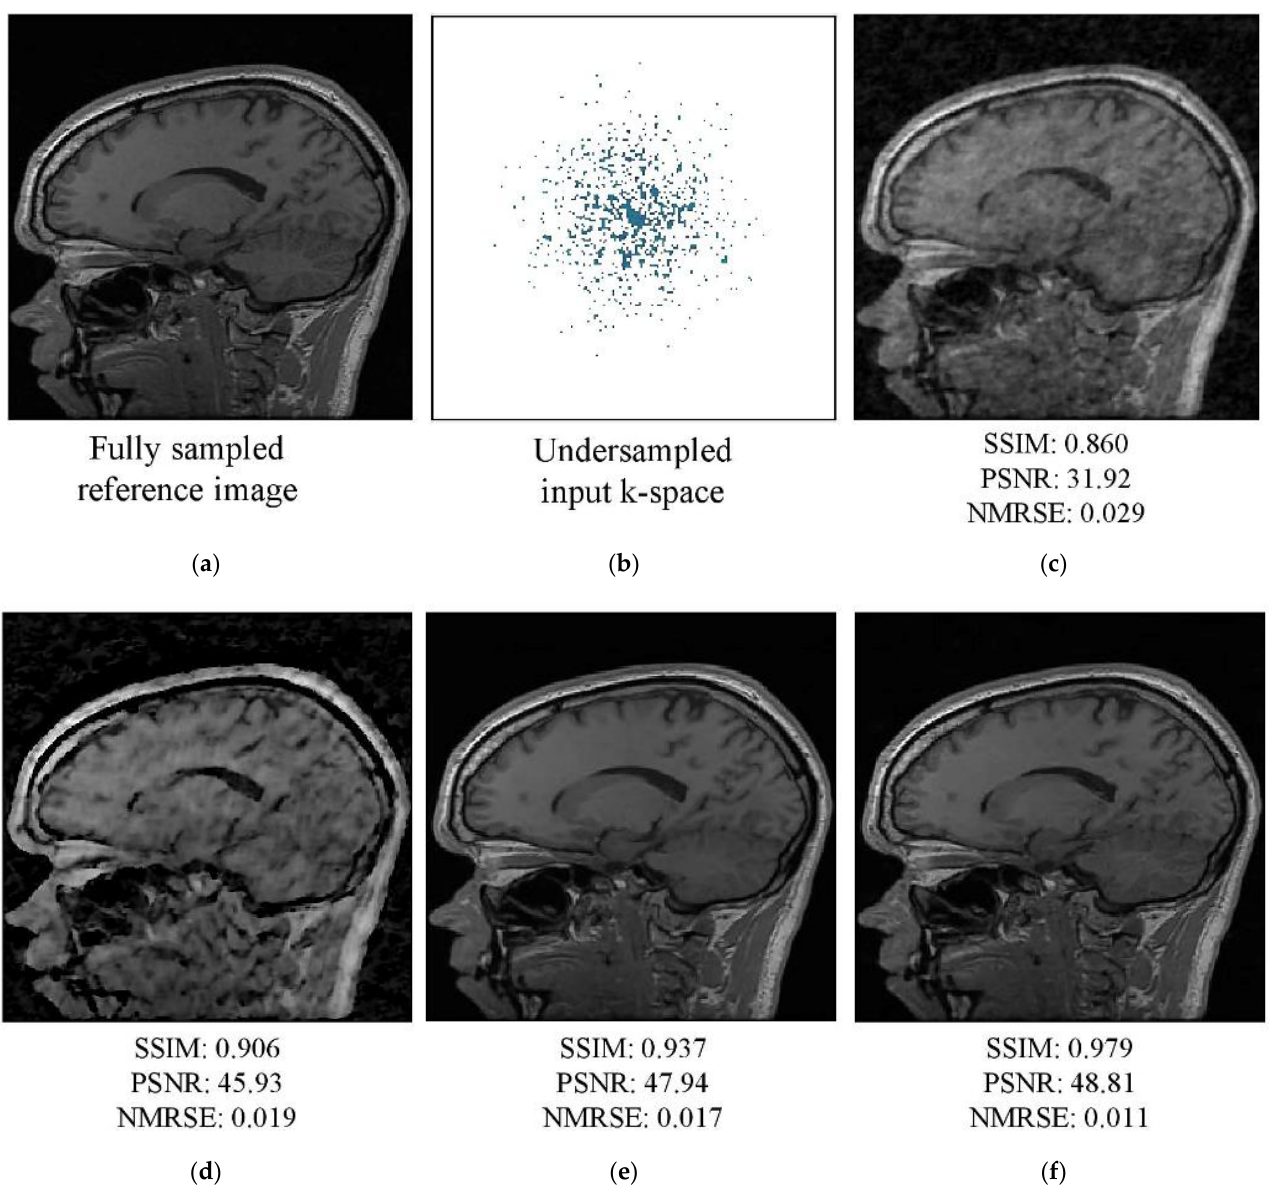
Figure 7. MRI images from the test dataset (slice No. 100) for acceleration factor (AF) 4: ( a ) fully sampled reference image and ( b ) undersampled k-space. Image reconstructed by the ( c ) inverse fast Fourier transform (IFFT), ( d ) Unet, ( e ) W-net, and ( f ) RA-CNN methods.